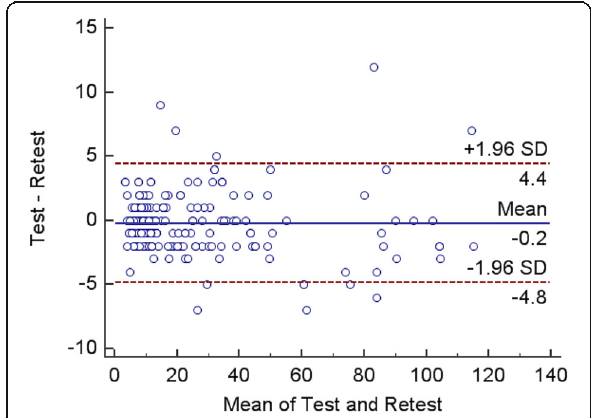
Fig. 1 Bland and Altman plot for agreement showing narrow margin of bias from upper limit (4.40) and lower limit ( − 4.83) to the arithmetic mean difference of test and retest measurements, which indicate an excellent degree of reliability. Blue line indicates mean difference. Dashed red line indicates 95% confidence interval of difference